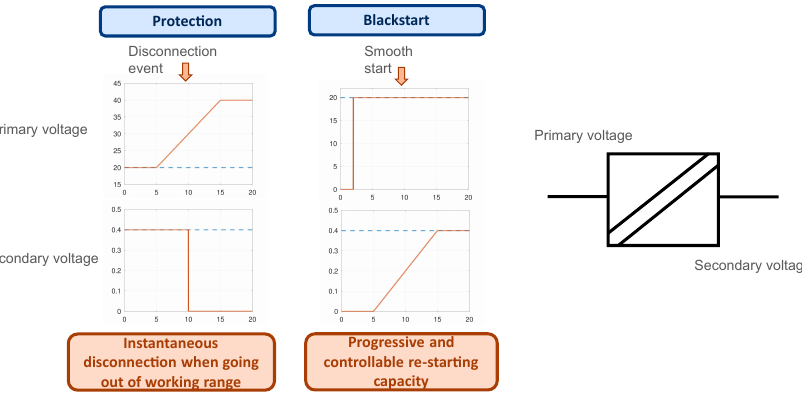
Figure 6. Protection and black-start SST features. SSTs can be disconnected instantaneously if a programmed threshold is fired; whenever the power grid comes back again, the re-starting process can be performed in a progressive and controlled